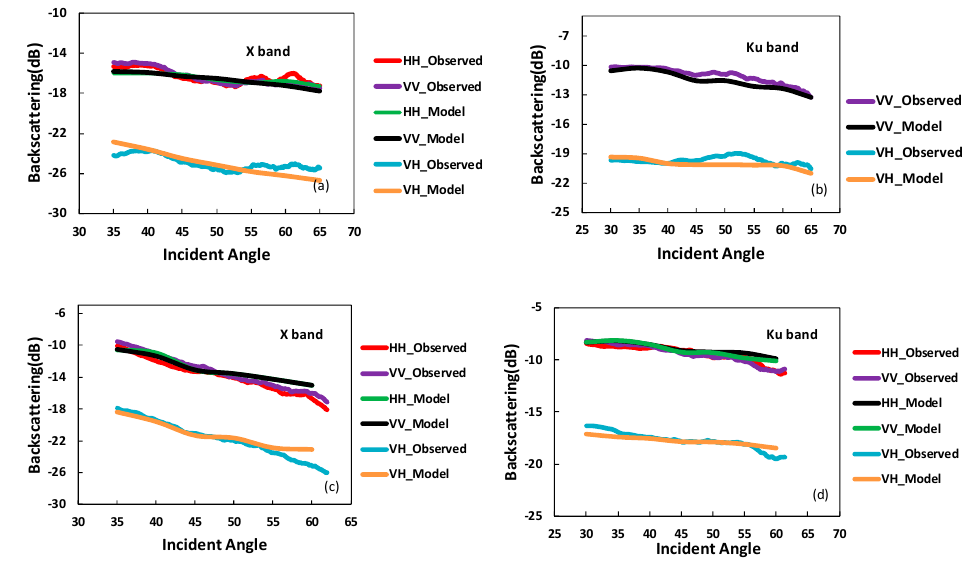
Figure 1. Comparison of the GB-SAR observed with the model predicted backscattering on 17 January 2007 ( a ) at X band and ( b ) at Ku band; and 5 February 2007 ( c ) at X band and ( d ) at Ku band. Table 3. Comparison between simulated backscattering and observed backscattering. X